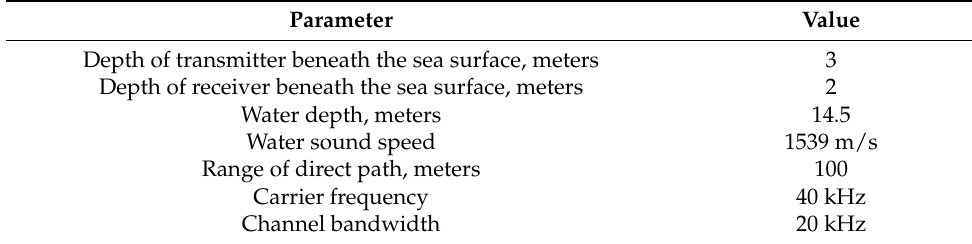
Table 2. Parameters of the adopted underwater channel model [26]. Parameter Value Depth of transmitter beneath the sea surface, meters 3 Depth of receiver beneath the sea surface, meters 2 Water depth, meters 14.5 Water sound speed 1539 m/s Range of direct path, meters 100 Carrier frequency 40 kHz Channel bandwidth 20 kHz And 10% were 14.0671, 14.5223, and 14.9894 dB, respectively, for the proposed